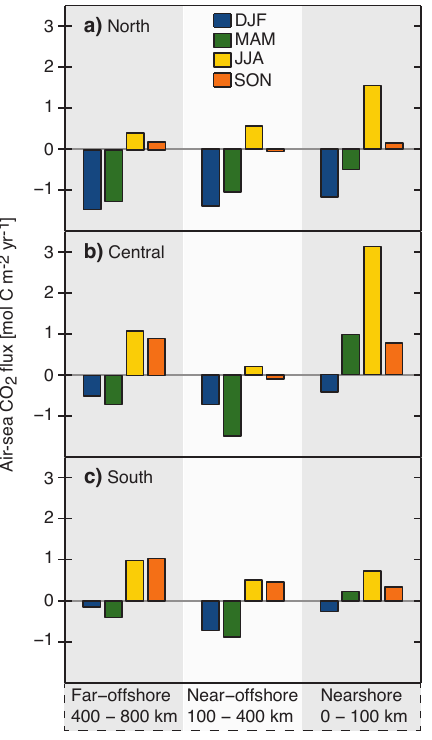
Fig. 5. Seasonally averaged air–sea CO 2 flux for the northern (a) , central (b) and southern (c) subdomains in the nearshore, near- offshore and far-offshore regions. Positive values denote an out- gassing of CO 2 , negative values an uptake by the surface